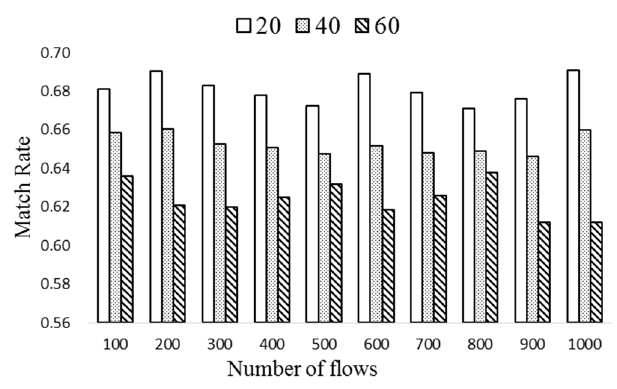
Figure 9. The match rates of ExTable with different Δ T .